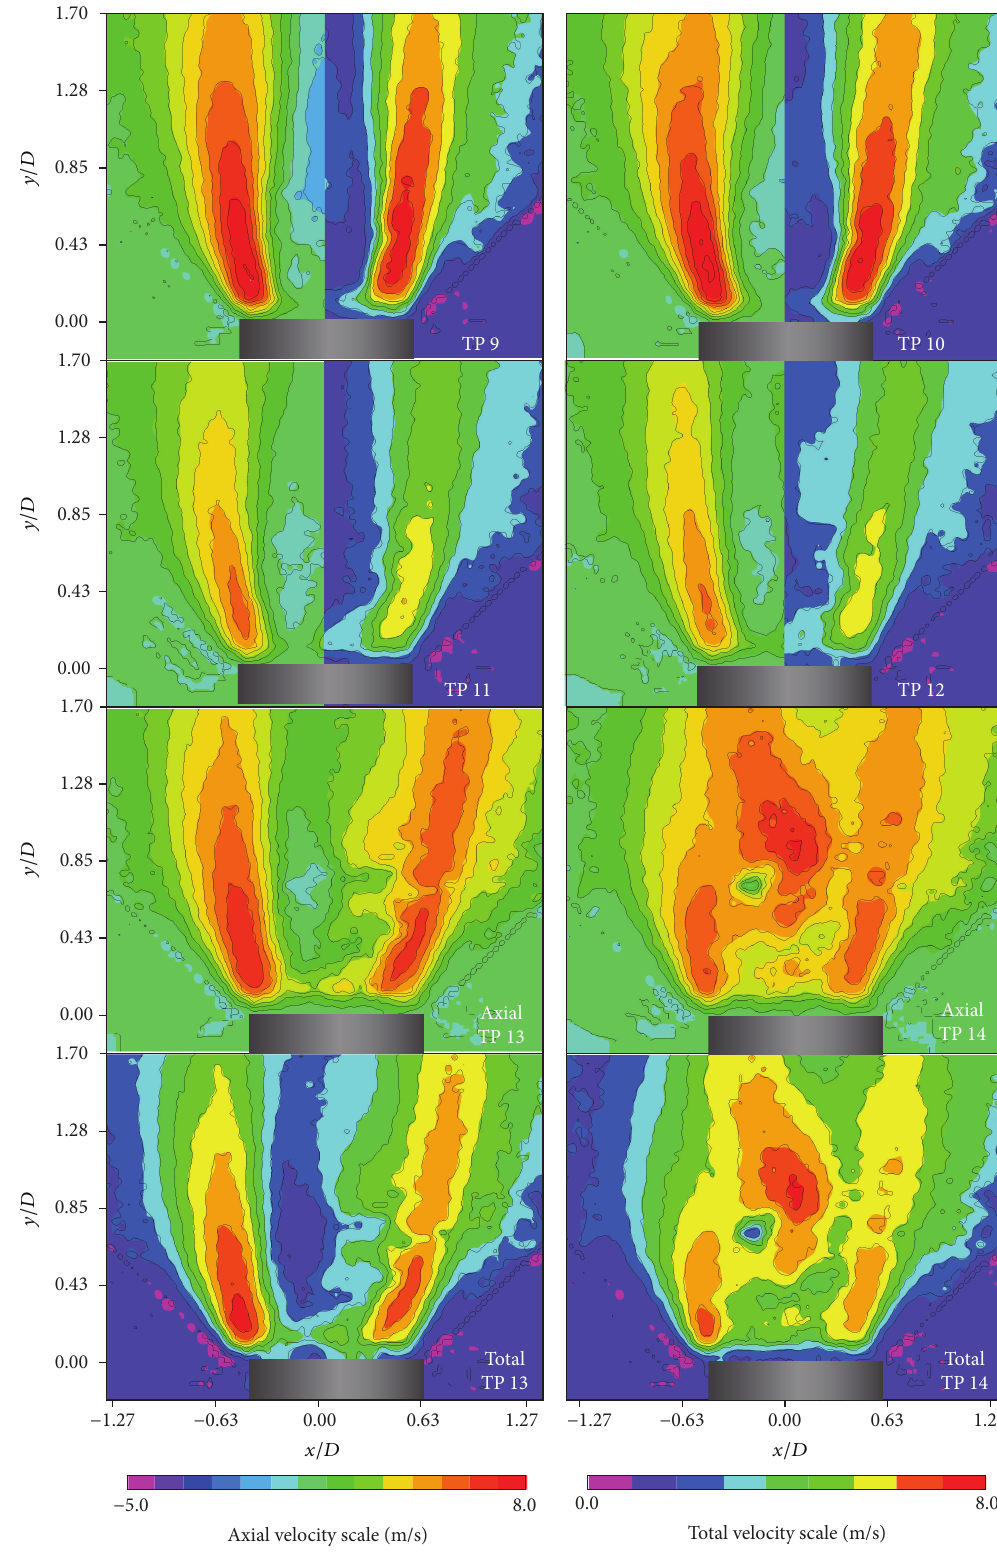
Figure 4: Scalar plots of TP 9 to TP 14 in the AGSB as detailed in Table 1, TP 9 to TP 12 the left half of each image indicates axial velocity, and the right half total velocity. TP 13 and TP 14 show full frames of axial and total